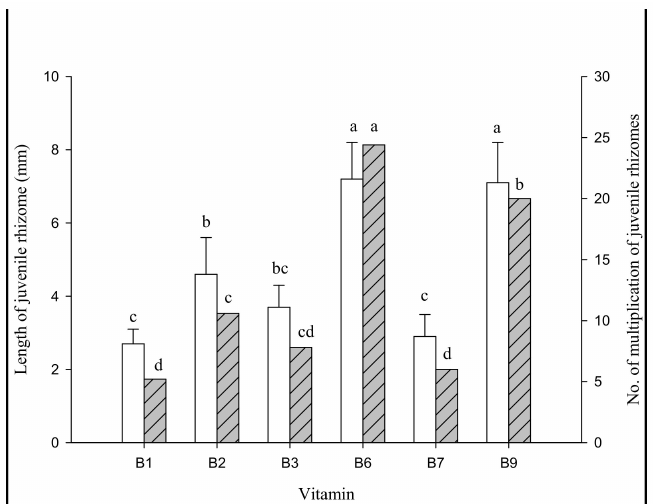
Figure 7. Effect of addition B vitamins on growth and proliferation of G. elata juvenile rhizomes after 8 weeks in YH2 basal medium without B complex added. Each value is expressed as mean ± SD (n = 5). Means followed by the different letter(s) are significantly different at p < 0.05 by Fisher’s protected LSD test. a,b,c,d Mean values with unlike letters were significantly different. YH2: YH1 + 3.5 g/L gelrite (to replace 8 g/L agar) B vitamins: 0.1 mg/L B1; 0.5 mg/L of B2, B3, B6, B9 each; and 1 mg/L